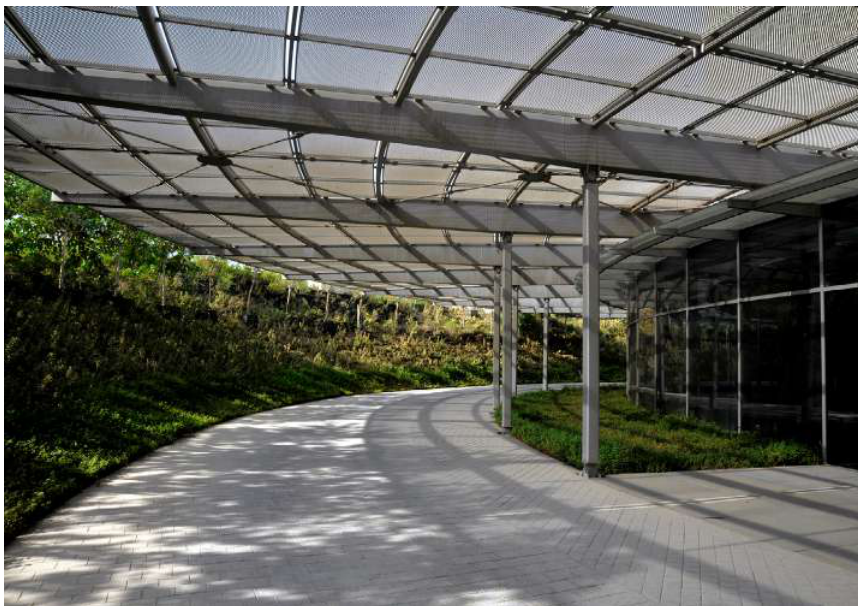
Burj Qatar ‘grotto’ one level be - low street level (Source: Peter Chomowicz,